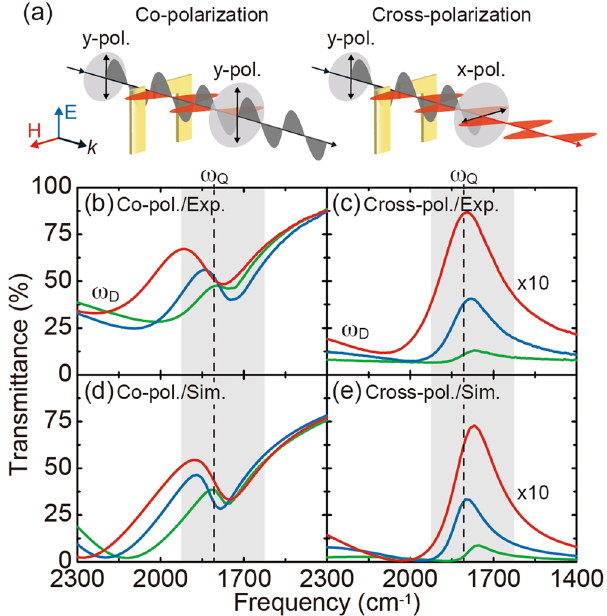
Figure 3. IR characterization of metamaterials. ( a ) Experimental setups of FT-IR transmission measurement for the co- and cross-polarizations. Experimentally measured transmission spectra of the metamaterials for the ( b ) co- and ( c ) cross-polarizations. ( d , e ) Corresponding numerical simulations, which well reproduced the experimental results qualitatively and quantitatively. The excitation of the Fano resonance in the shaded region is manifested as a transmission dip for the co-polarization, but as a transmission peak for the cross-polarization. The spectra in ( c ) and ( e ) have been multiplied by 10 for